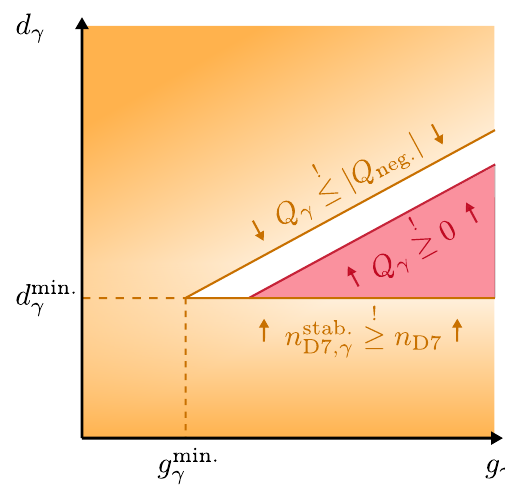
Figure 1 . Orange: the degrees d γ and genera g γ of flux curves γ that our calculations rule out as leaving unfixed D7 moduli or as incompatible with tadpole cancelation. Red: fluxes that our calculation does not rule out but which give a negative tadpole contribution and are hence